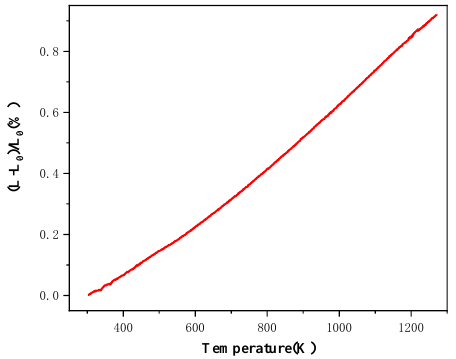
Figure 8. Thermal expansion curves of CSYG-15%BIT07.